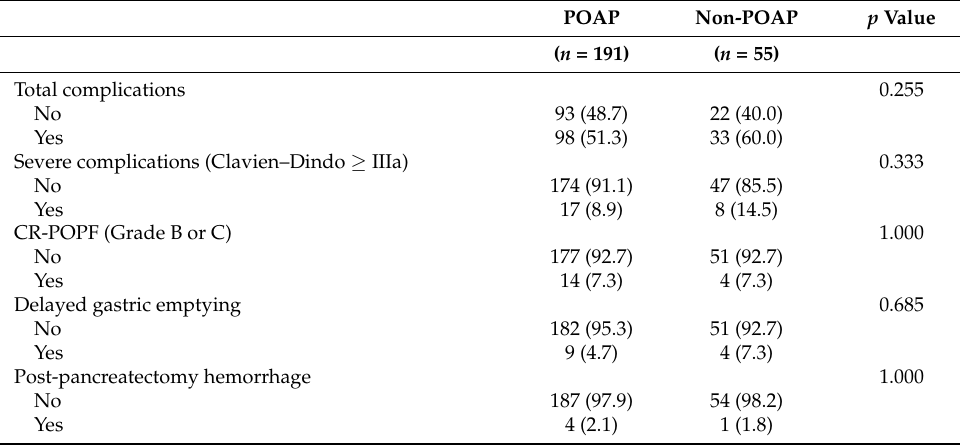
Table 2. Postoperative